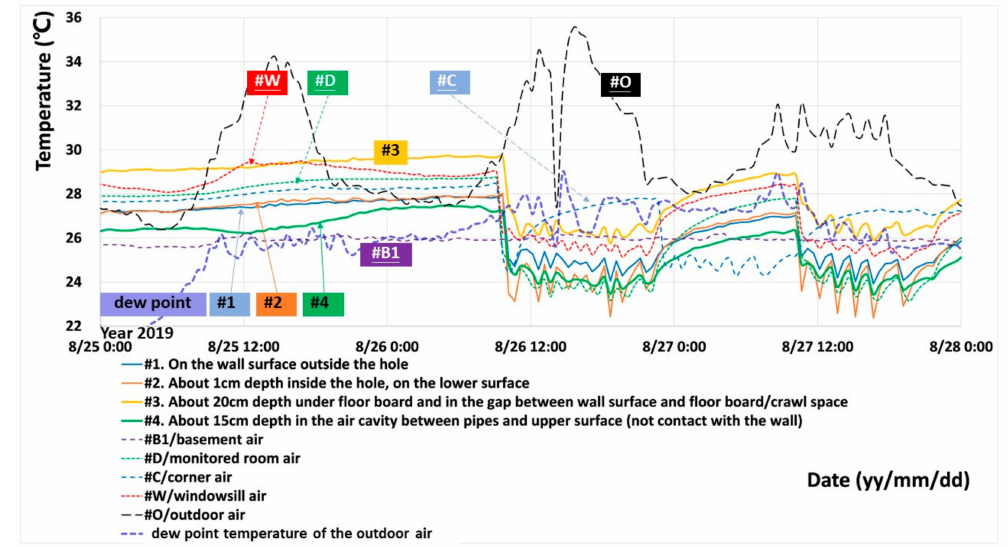
Figure 15. The temperatures around the air cavity (25–27 August